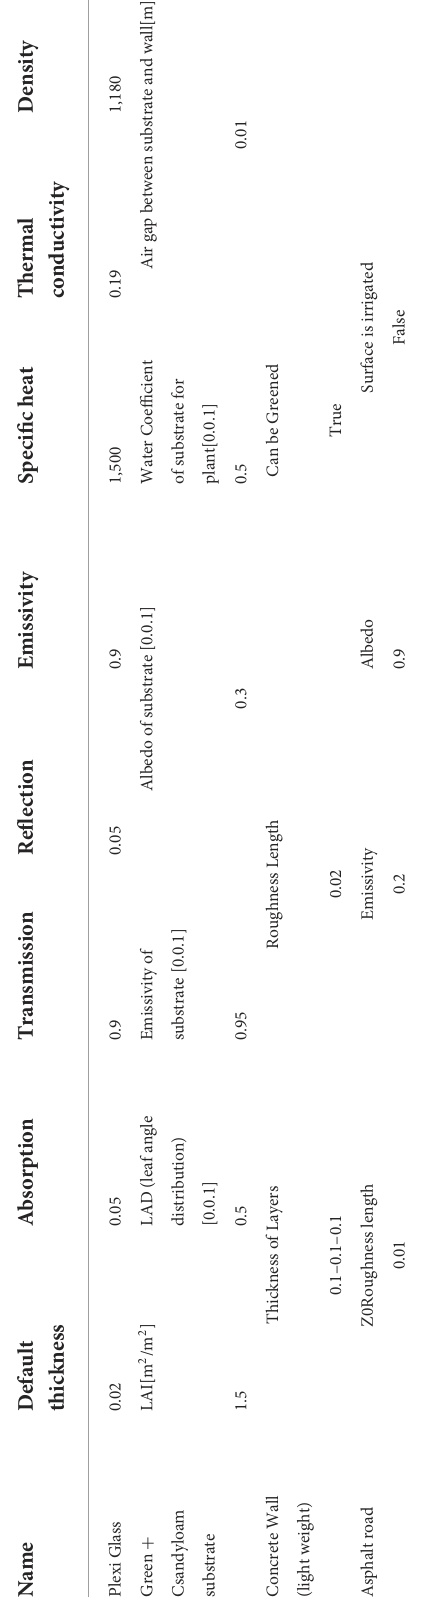
TABLE 2 Placement of pollution sources and